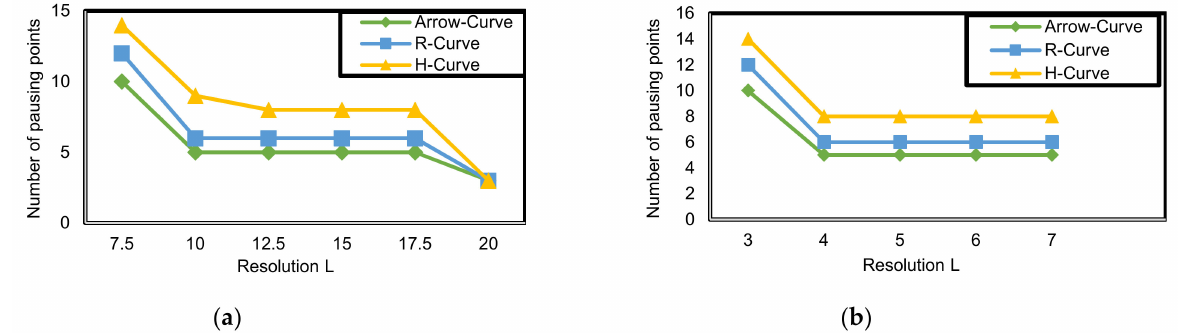
Figure 23. Number of pausing points (PP) corresponding to resolution (L) in Arrow-Curve model, R-Curve path model, and H-Curve: ( a ) outdoor environment; ( b ) indoor